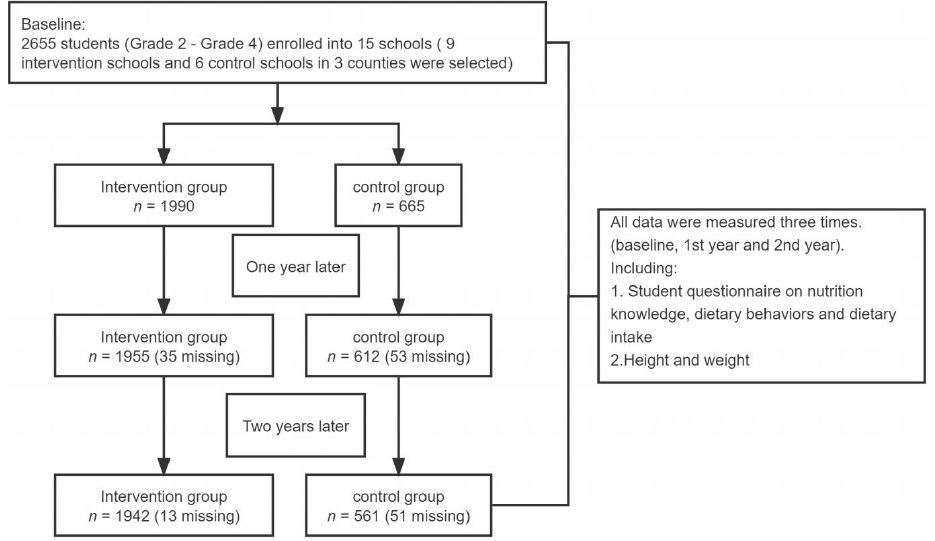
Figure 1. Flow diagram of participation.